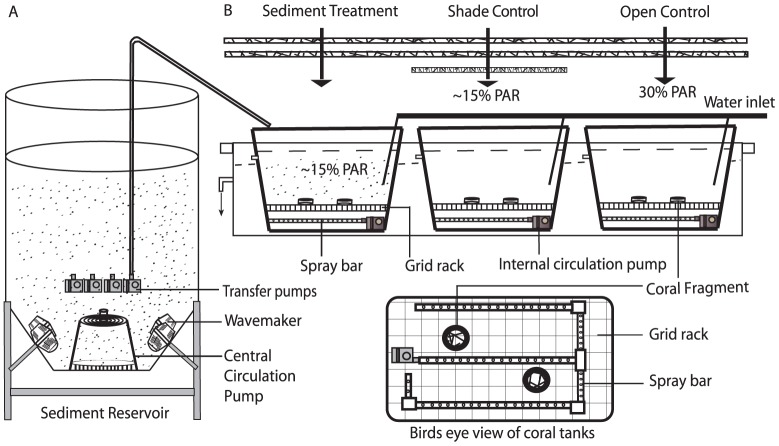
Experimental setup.(A) Sediment reservoir, (B) Coral treatment tanks. Four tanks for each treatment (sediment, shade, open) were placed in a water bath positioned under a shade cloth which reduced ambient light to 30%. Additional shading was placed over the shaded to control which further reduced ambient light levels to 15%, comparable light levels to that of the sediment treatment tanks.